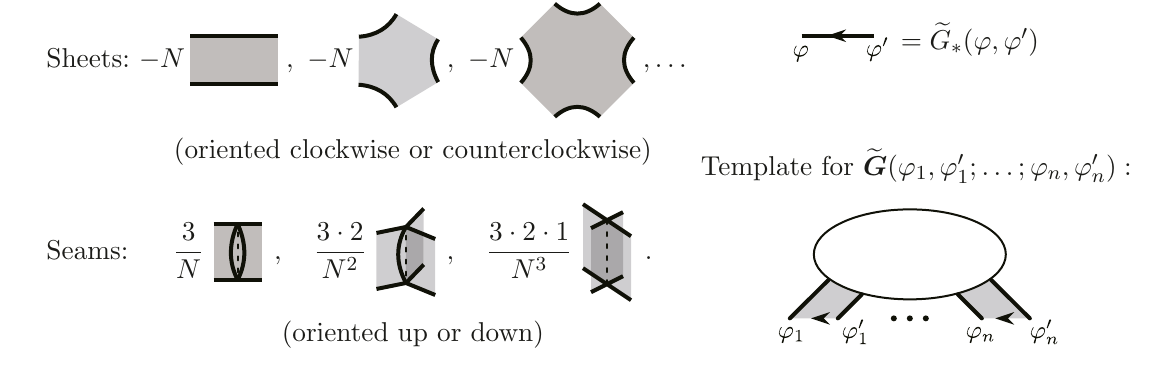
Figure 2 . Diagrammatic calculus for the expansion of action (2.8) around the saddle point ( for q = 4. Degenerate 2-gon sheets representing